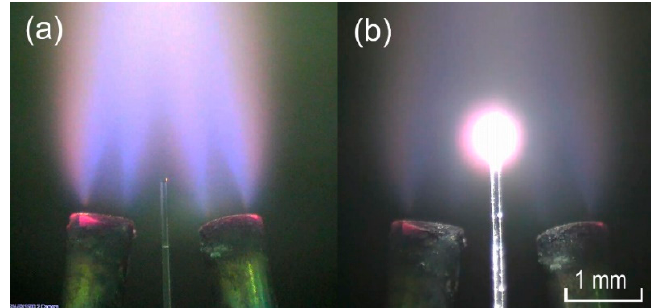
Figure 1. The process of forming a microsphere from an optical fiber in an oxygen-hydrogen burner flame: ( a ) The moment when the preform is introduced into the flame; ( b ) The formation of a microcavity. The Q-factor is mainly determined by the scattering of WGM radiation on various defects.